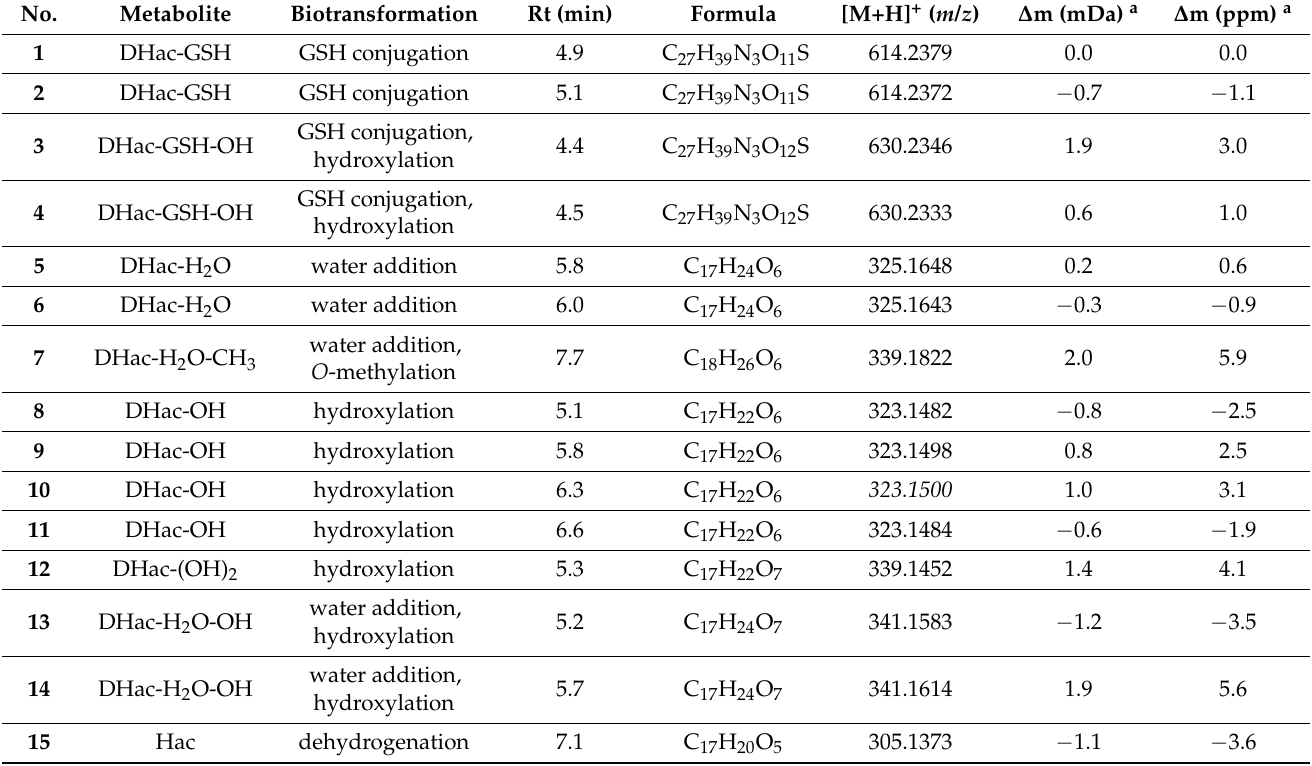
Table 1. Suggested biotransformation of DHac based on phase I and phase II metabolism experi- ments. Metabolites detected by UHPLC-(+ESI)-QqTOF MS are grouped by similar biotransformation reactions and characterized by their retention time (Rt), elemental formula, measured protonated molecule [M+H] + and mass deviations ( ∆ m—measured/calculated